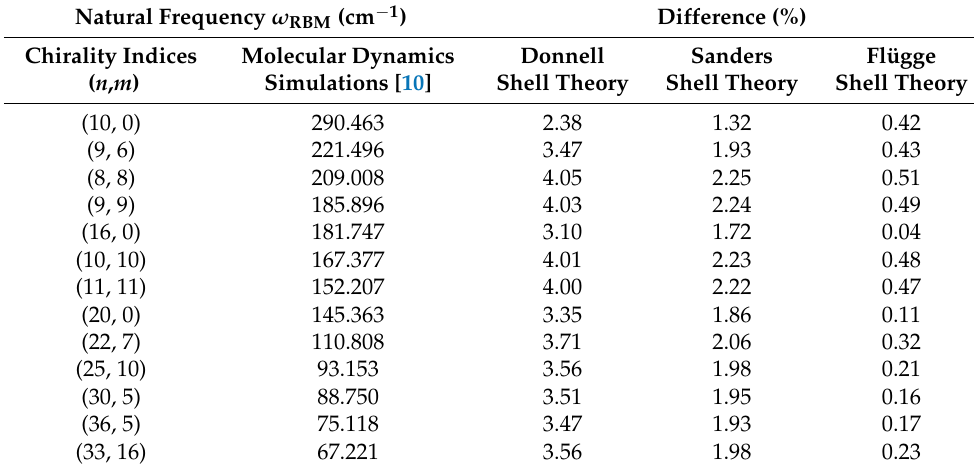
Table 2. Natural frequencies of the radial breathing mode ( q = 0, s = 0 ) of the SWCNT of Table 1 with aspect ratio. L / R = 10. Comparisons among Donnell, Sanders, Flügge shell theories and molecular dynamics